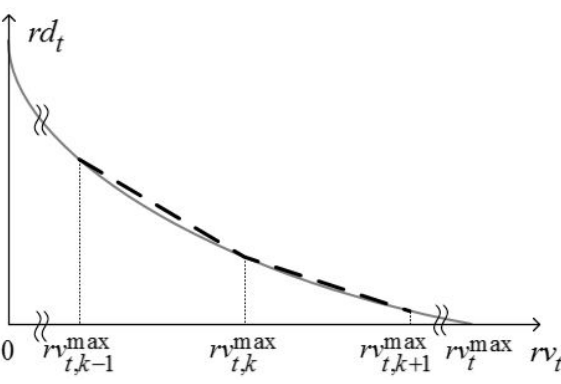
Figure 6. Piecewise linearization of reserve models.